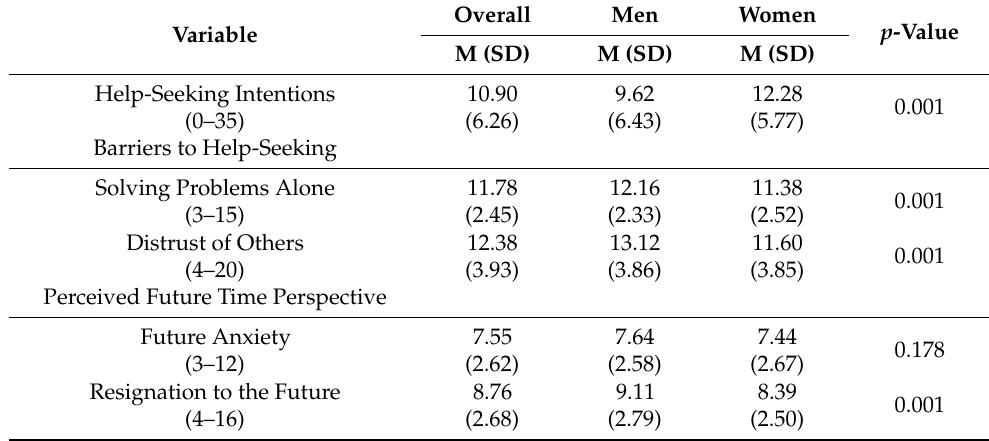
Table 4. Results of the t